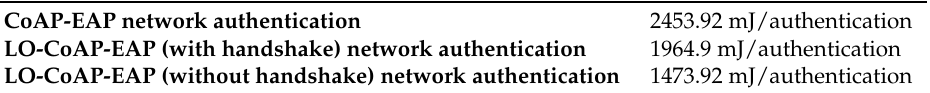
Table 8. Energy measurement in LoRaFabian.